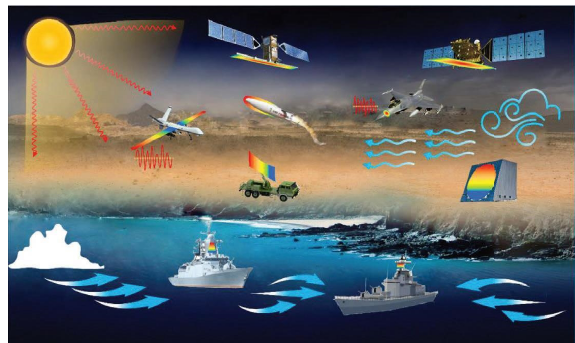
Figure 10: Service load of APAA on various